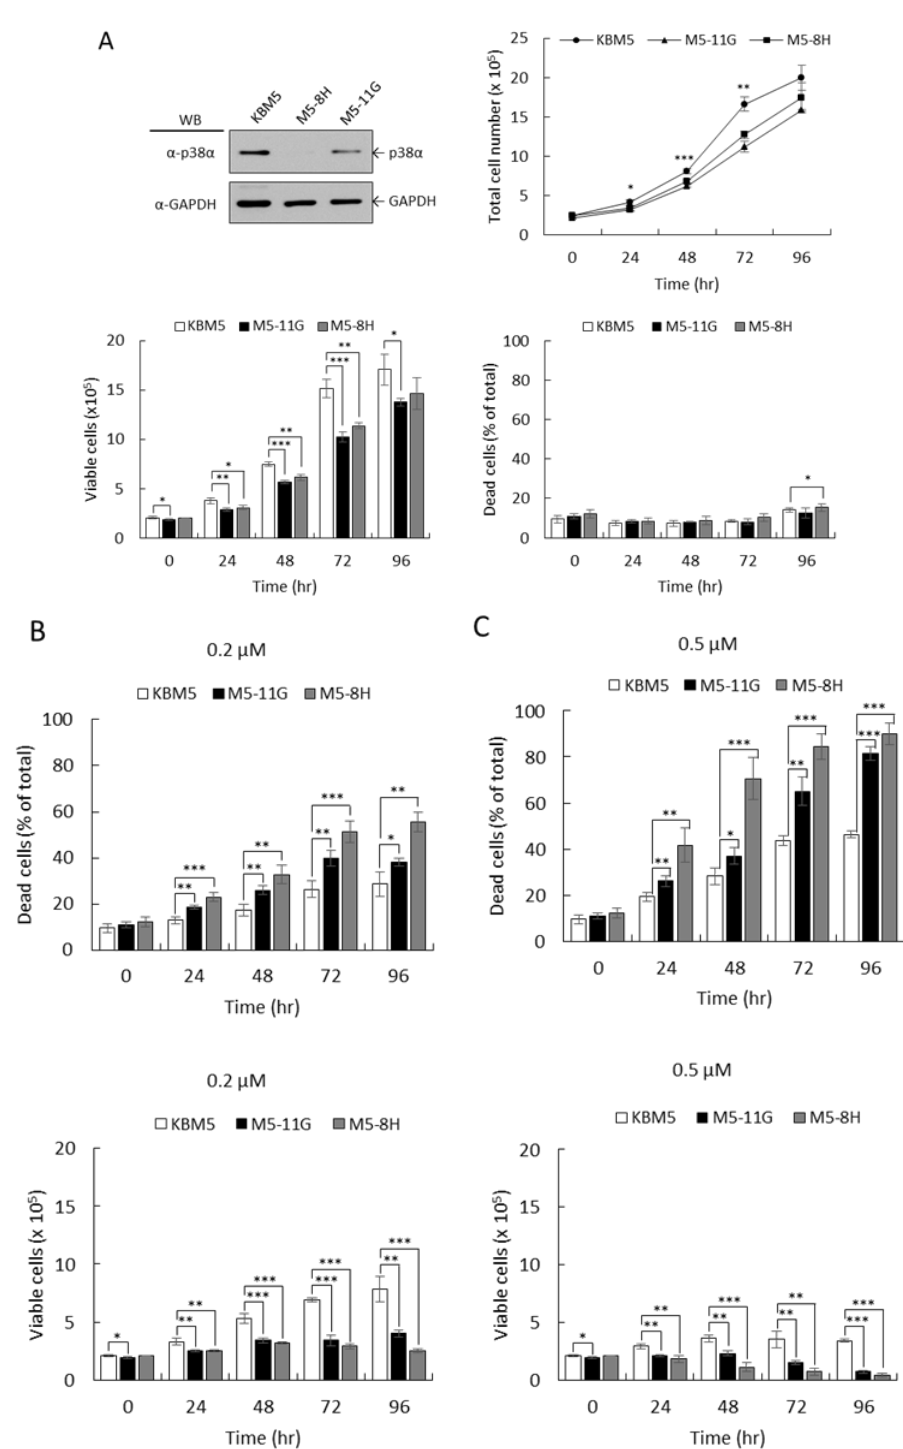
Figure 6. The p38 α deficiency increased cellular sensitivity to imatinib in BCR-ABL-positive KBM5 leukemia cells. The p38 α transcripts in KBM5 cells were knocked down using specific shRNAs. The protein levels of p38 α were examined by Western blotting ( A ). The cell growth and viability of parental KBM5 and knockdown M5-8H and M5-11G cell clones were examined using hemocytometer counting under a microscope ( A ). Dead cells were identified by trypan blue exclusion. Cells were treated with 0.2 ( B ) and 0.5 µ M ( C ) imatinib and the cell viability was examined. All results shown are representative of three independent experiments. Cell number and viability are presented as the mean ± SE of three repeats. * p < 0.05, ** p < 0.01, and *** p <